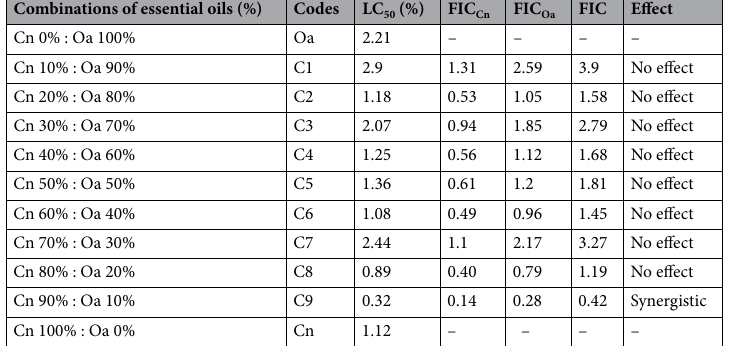
Table 7. Effects of combinations of essential oils of Cymbopogon nardus (Cn) and Ocimum americanum (Oa) on adults of Anopheles gambiae field strain of VK and type of interaction (n = 125 adult). LC 50 : lethal concentration for 50% mortality FI : FIC Cn + FIC Oa ; Synergistic: FIC < 0.5; Additive; 05 ≤ FIC ≤ 1; No effect: 1 ≤ FIC ≤ 4; Antagonistic: FIC > 4; Cn : Cymbopogon nardus ; Oa : Ocimum americanum; % :